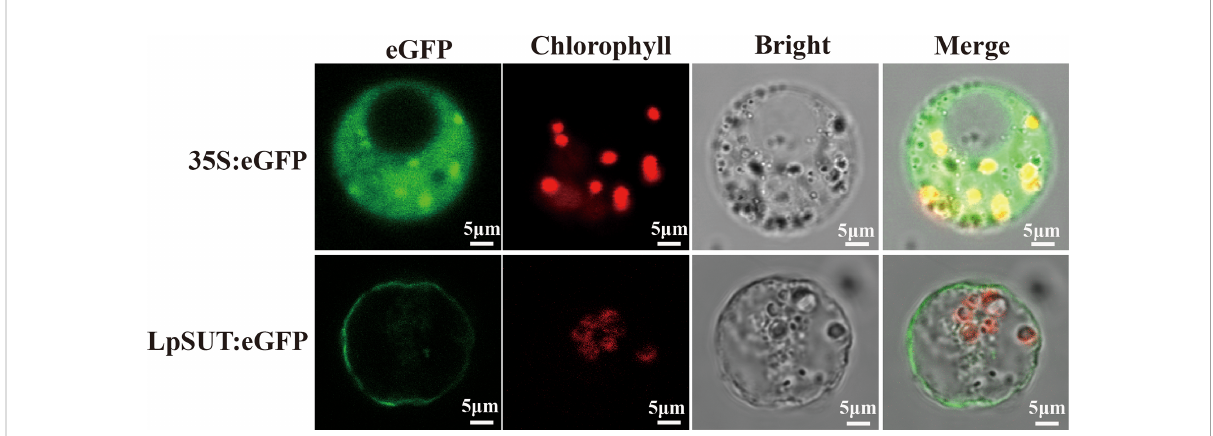
FIGURE 3 Subcellular localization of the LpSUT2. Transient expressions of the binary vector pCambia2301:eGFP and pCambia2301:LpSUT2:eGFP in the protoplast were observed under a laser scanning confocal microscope (excitation fi lter, 488 nm; emission fi lter bandpass, 505-530 nm). LpSUT2:eGFP fusion proteins were found located on PM. The eGFP protein is indicated in green, and chlorophyll auto fl uorescence is indicated in red. The eGFP, chlorophyll auto- fl uorescence, bright fi eld, and merged images were presented. Scale bar = 5 m m. LpSUT2, Sucrose transporter 2 of L. punctata ; eGFP, Enhanced green fl uorescent protein.